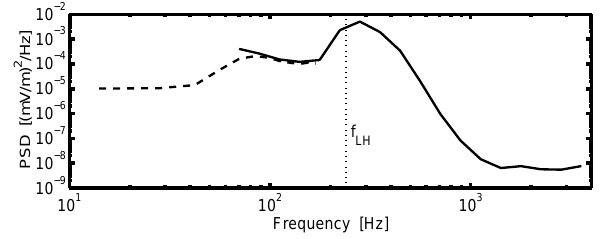
Fig. 10. Spectrum of the background wave electric power spectral density for the Cluster events in the example in Fig. 2. The solid line is obtained using STAFF data and the dashed line is from EFW data. The lower hybrid frequency is indicated for comparison.